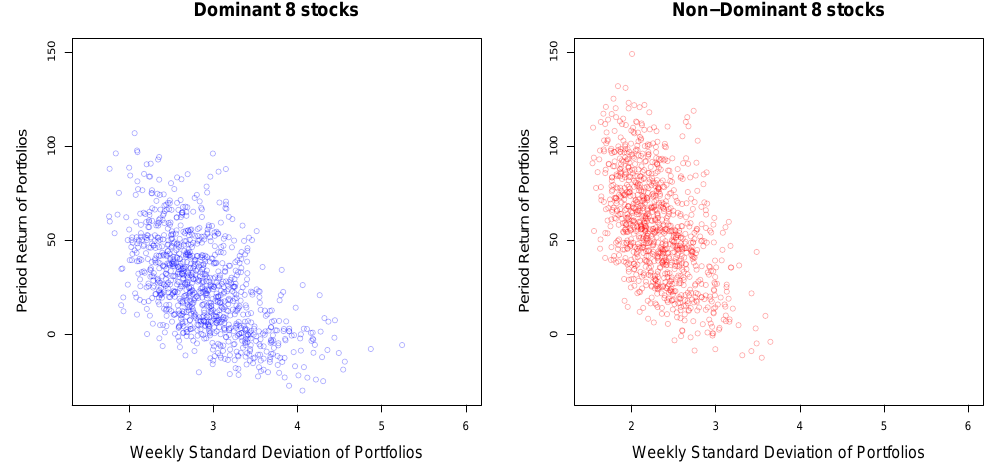
Figure 11. Scatter plots of Period 6 returns against the weekly volatility for the eight-stock portfolios selected on the basis of the clusters identified in neighbor-Nets splits graph from Period 5 with the clusters split into dominant and non-dominant industry